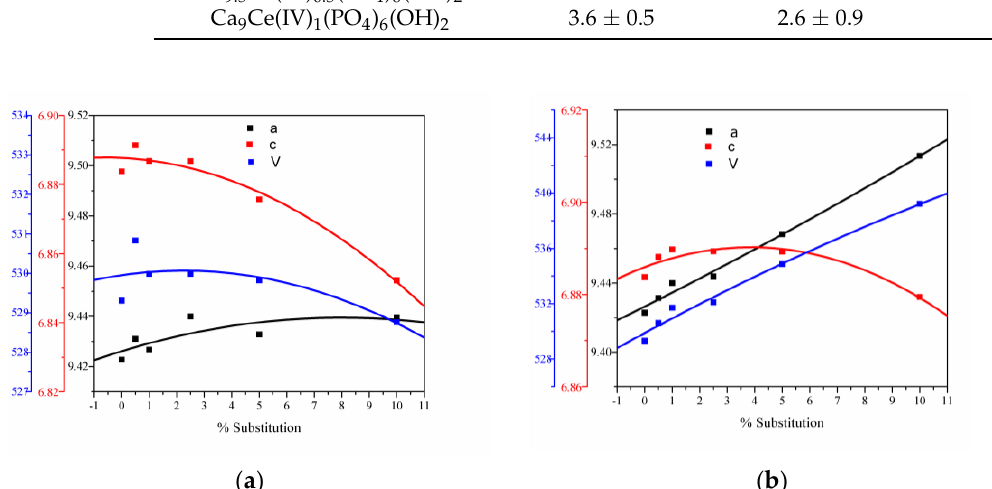
( a ) ( b ) Figure 3. ( a ) Unit cell parameters versus substitution degree for Ca 10 − x Ce(III) x (PO 4 ) 6 (OH) 2 ; ( b ) unit cell parameters versus substitution degree for Ca 10 − x Ce(IV) x (PO 4 ) 6 (OH) 2 . ( a ) ( b ) Table 1. Calculated crystallite size (D), internal strains (S) values, and degree of crystallinity (χ c ) of Figure 2. ( a ) X-ray diffraction patterns of hydroxyapatite (HAp) and Ca 10 − xCe(III)x(PO4) 6 (OH) 2 ; ( b ) X-ray diffraction pat- pure HAp, cerium (III)-doped hydroxyapatite and cerium (IV)-doped hydroxyapatite with various terns of hydroxyapatite (HAp) and Ca 10 − xCe(IV)x(PO4) 6 (OH) 2 . concentrations.